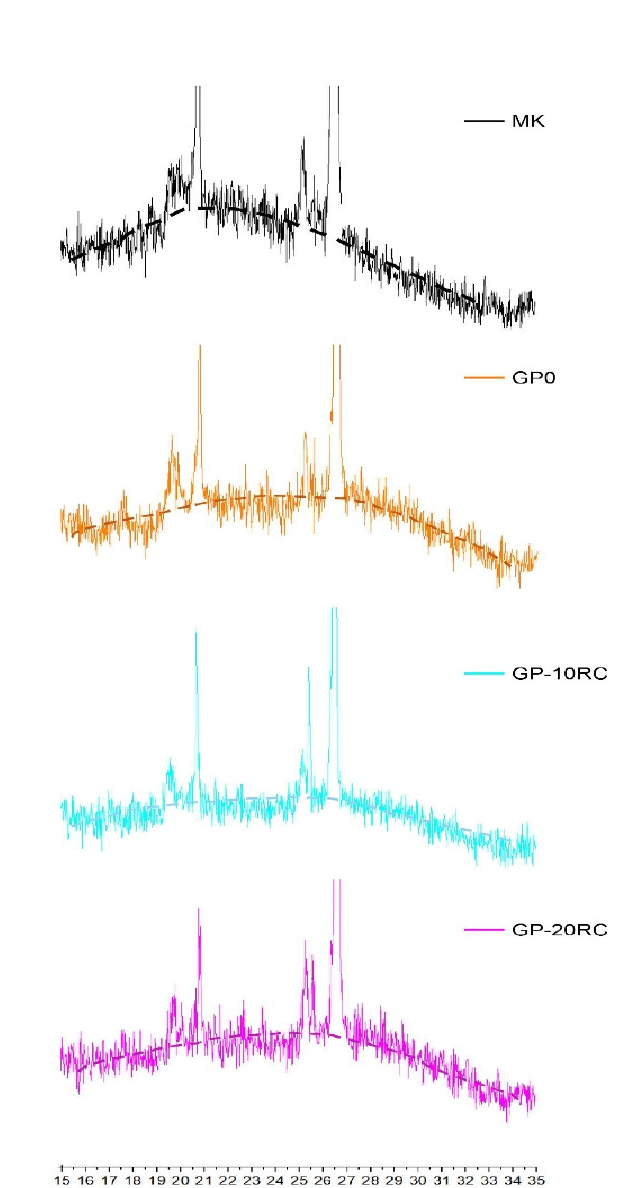
Figure 5. XRD patterns for: ( A ) RC raw materials and RC post basic attack of NaOH at different concentrations. ( B ) MK and GP0, GP-10RC and GP-20RC corundum based geopolymers. Crystalline phases identification label: Q = Quartz, K = Kaolinite, A = Anatase, I = Illite. ( C ) Enlargement of B spectra in the range 20–35° in 2 theta.